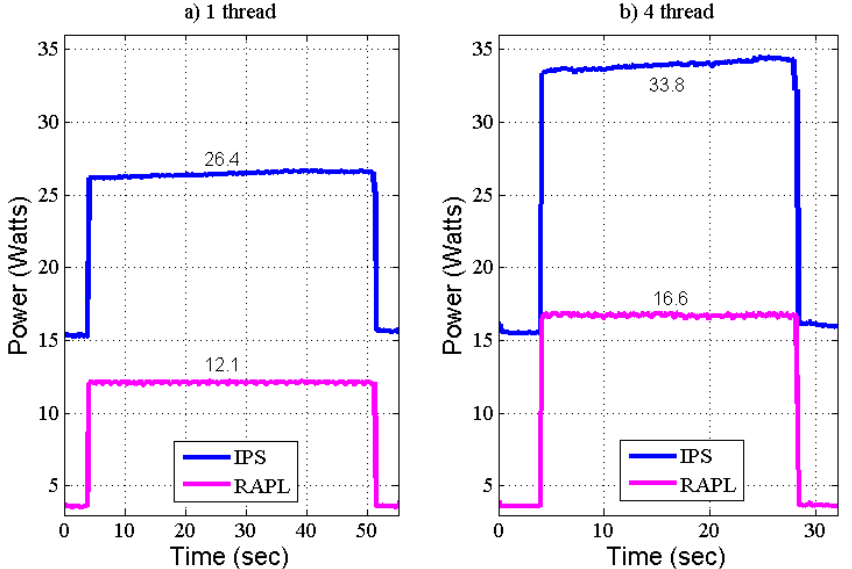
Figure 4. Testbench of Internal RAPL vs. External